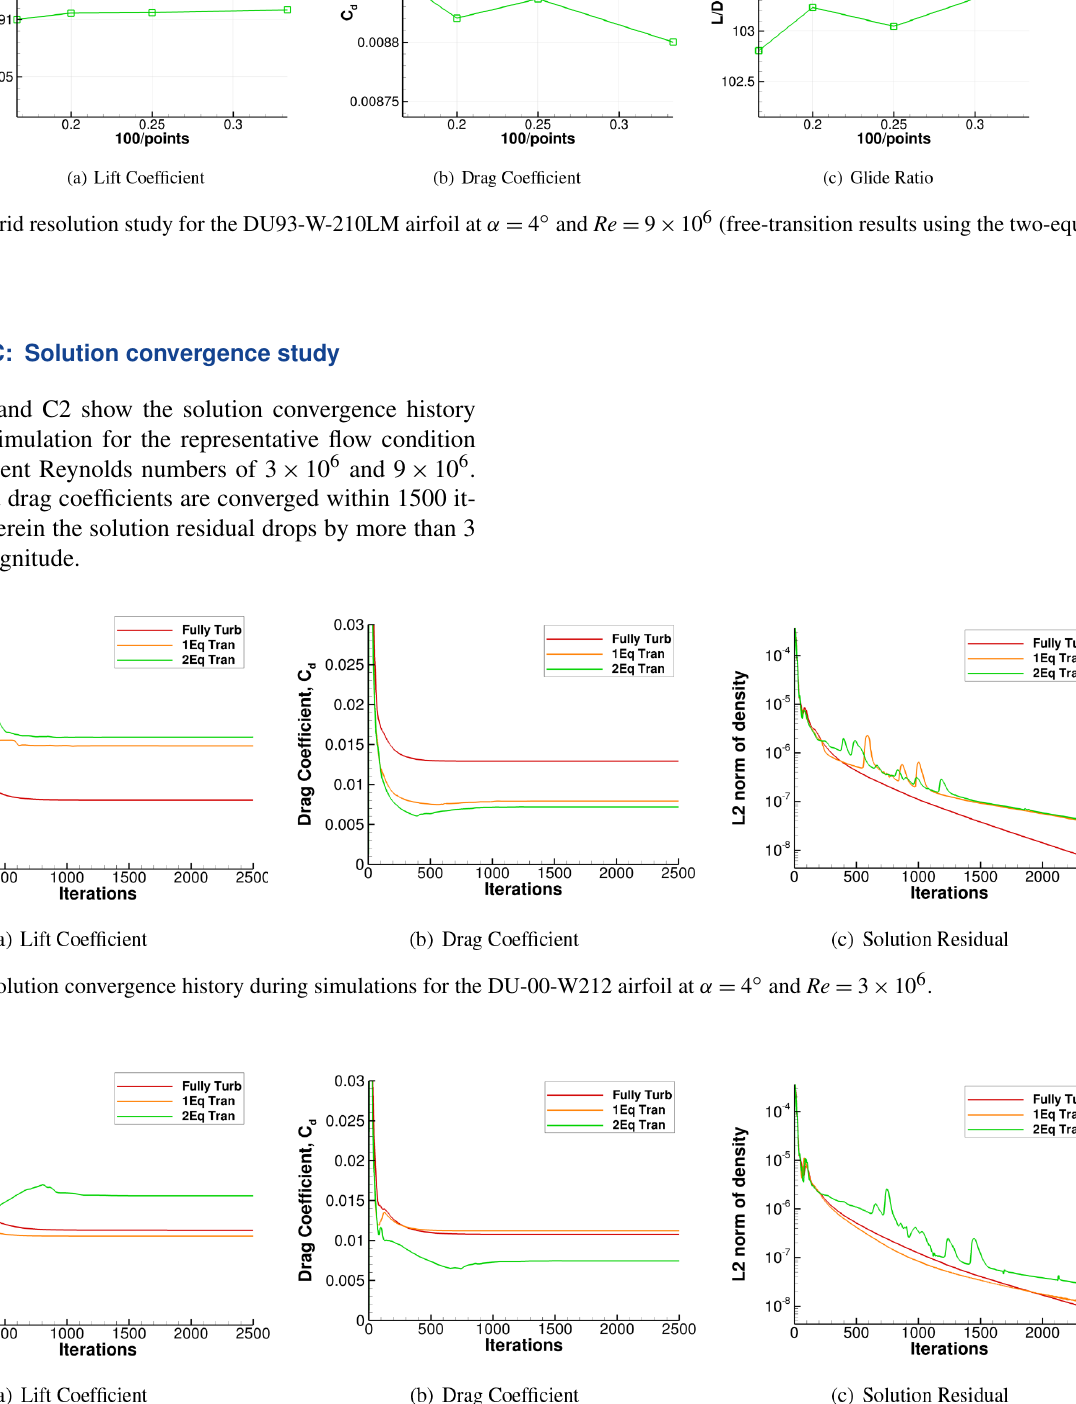
Wind Energ. Sci., 7, 603–622,